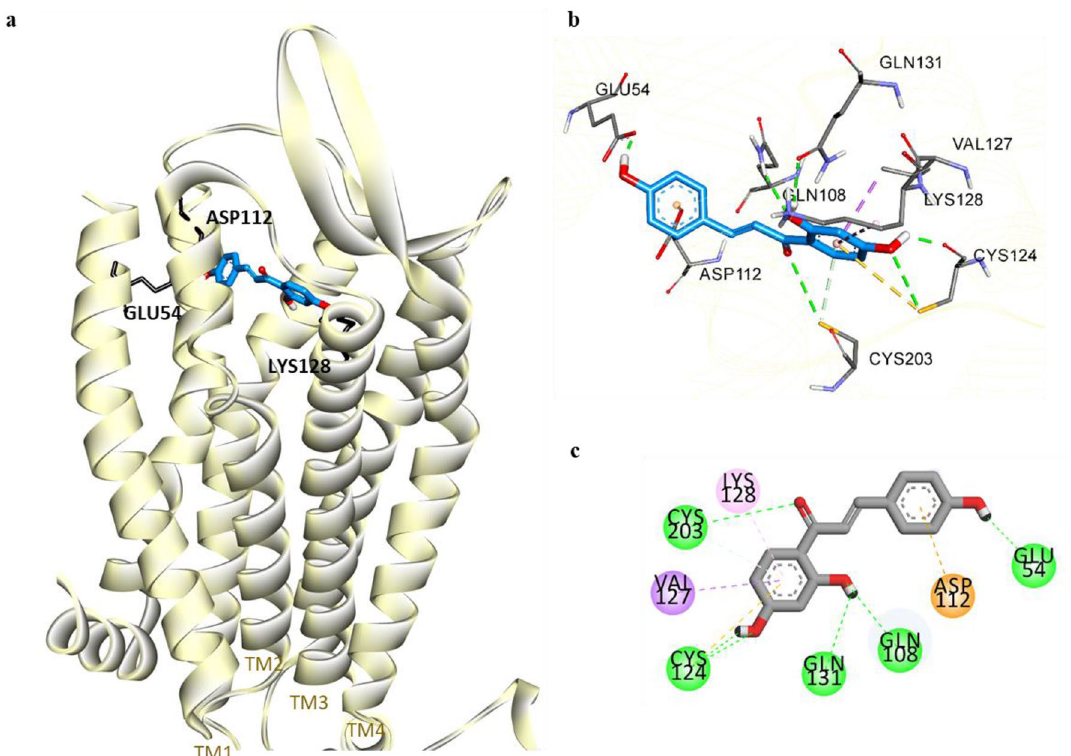
Figure 7. Molecular docking of isoliquiritigenin (ILG) (blue stick) to hV 1A R ( a ). Close-up view of ligand binding pocket of hV 1A R in complex with ILG ( b ). Two-dimensional binding diagram showing interactions of ILG-hV